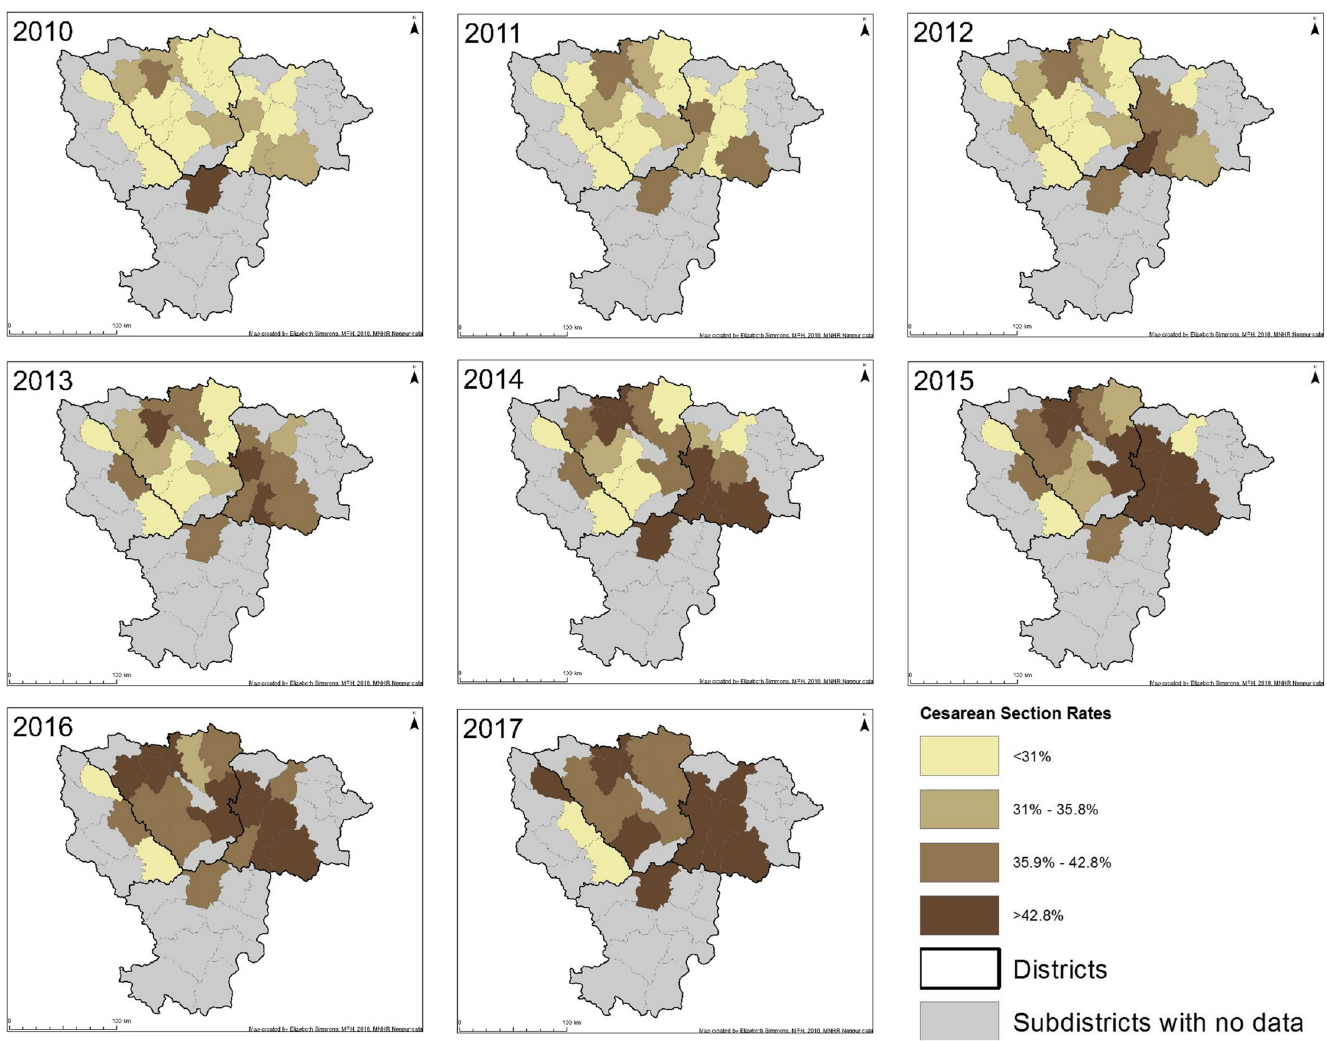
Fig 4. Change in subdistrict population-based cesarean section rate from 2010 to